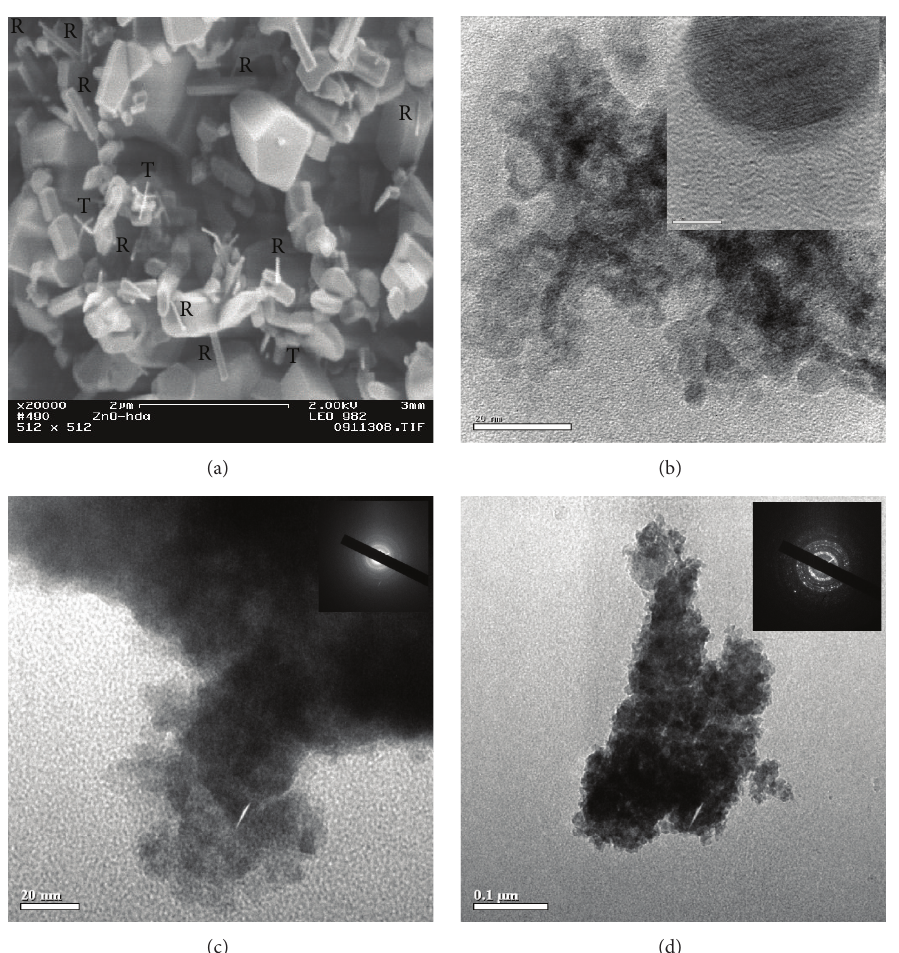
Figure 2: (a) SEM picture of particles of submicronic powder (target) ZnO (designation: T, nanotetrapods; R, nanorods); (b) TEM NP ZnO- Zn picture (on the insert, core-shell nanoparticle ZnO with amorphous shell); (c) TEM picture NP ZnO-Zn-Fe (on the insert, the electron diffraction pattern from theamorphous area of sample); (d) TEMpicture of agglomerate nanoparticles ZnO-Zn-Fe(on the insert, theelectron diffraction pattern from the crystalline area of